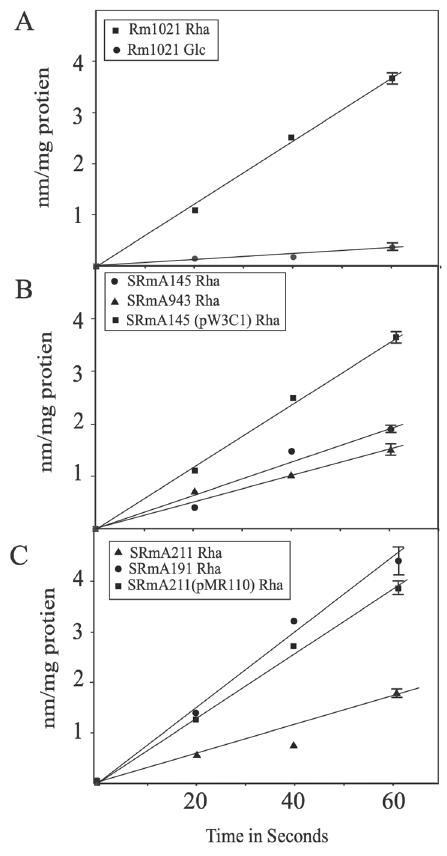
Figure 2. Rhamnose transport assays. Strains were grown to mid-log phase in defined medium containing either glucose/glycerol (Glc) or rhamnose/glycerol (Rha) as indicated. Transport rates were determined using ( 3 H) rhamnose as described in materials and methods. ( A ) Rhamnose uptake between Rm1021 grown on glucose or rhamnose. ( B ) Comparison of rhamnose uptake of induced ABC transporter mutants and complemented transporter mutant. ( C ) Rhamnose transport by induced kinase and isomerase mutants as well as a complemented kinase mutant. Symbols for strains are indicated on the figure inset. The data shown represent averages of biological three replicates. Error bars represent standard deviation. Where not seen, error bars are smaller than the representative symbols. Data shown in all three panels were carried out at the same time. For clarity, the data is presented in three separate panels.